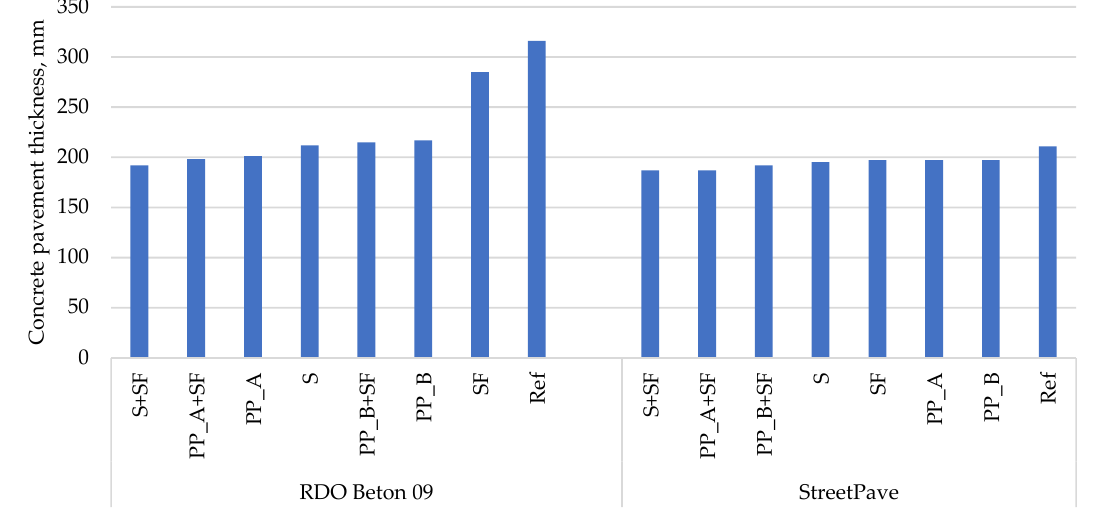
Figure 3. Calculated PCP thicknesses on hydraulically bound base.